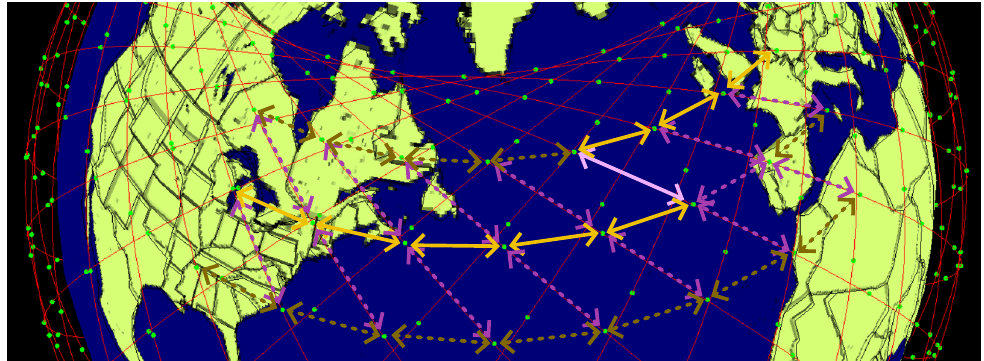
Figure 1. Part of a constellation showing the ISLs between neighboring satellites. Orange arrows show links between adjacent planes and pink arrows show links between consecutive satellites in the same orbital plane. The non-dashed links show a possible path between Western Europe and the Great Lakes region in the USA.